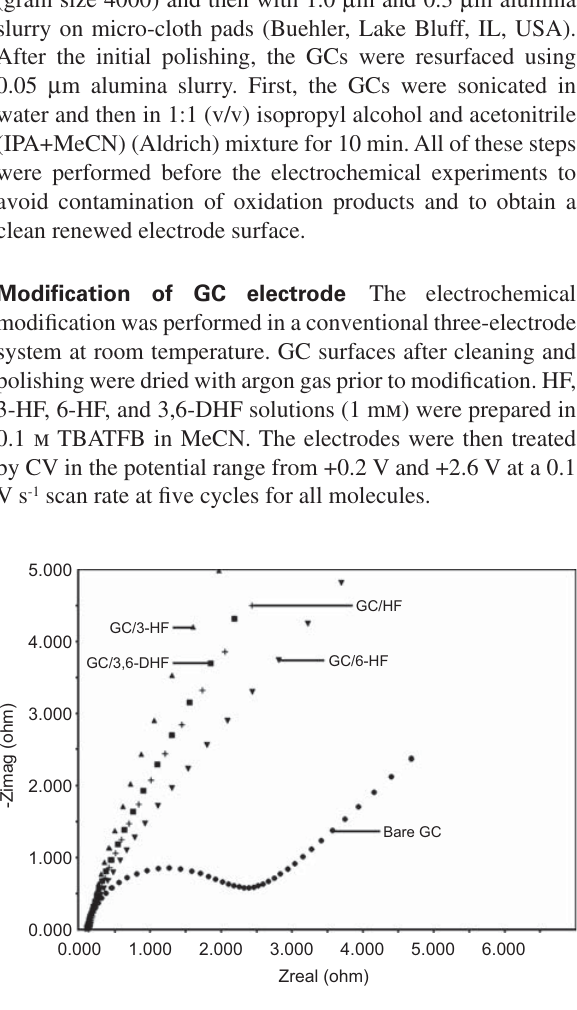
Figure 6 Overlaying the impedance plots obtained by 1 m m 3-/4- redox probe in 0.1 m Fe(CN) 6